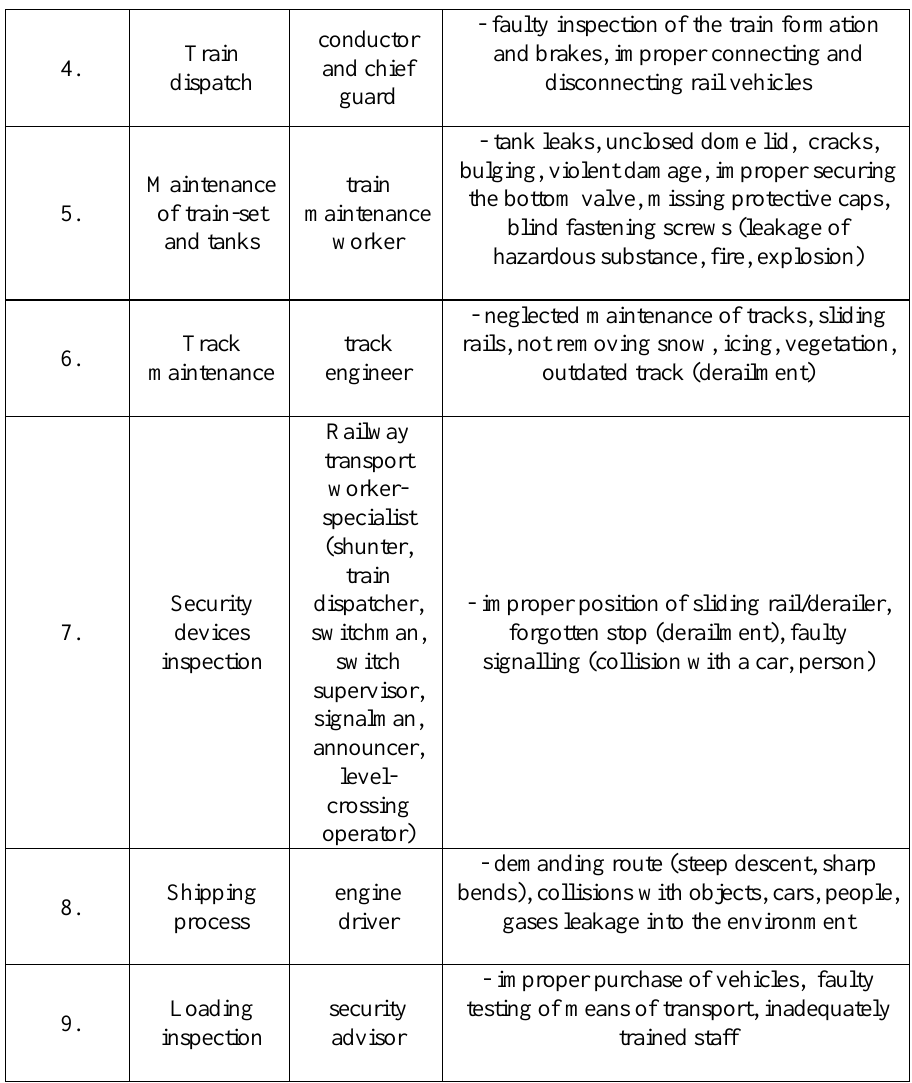
Table 6 Application of point method for expressing threat and risk